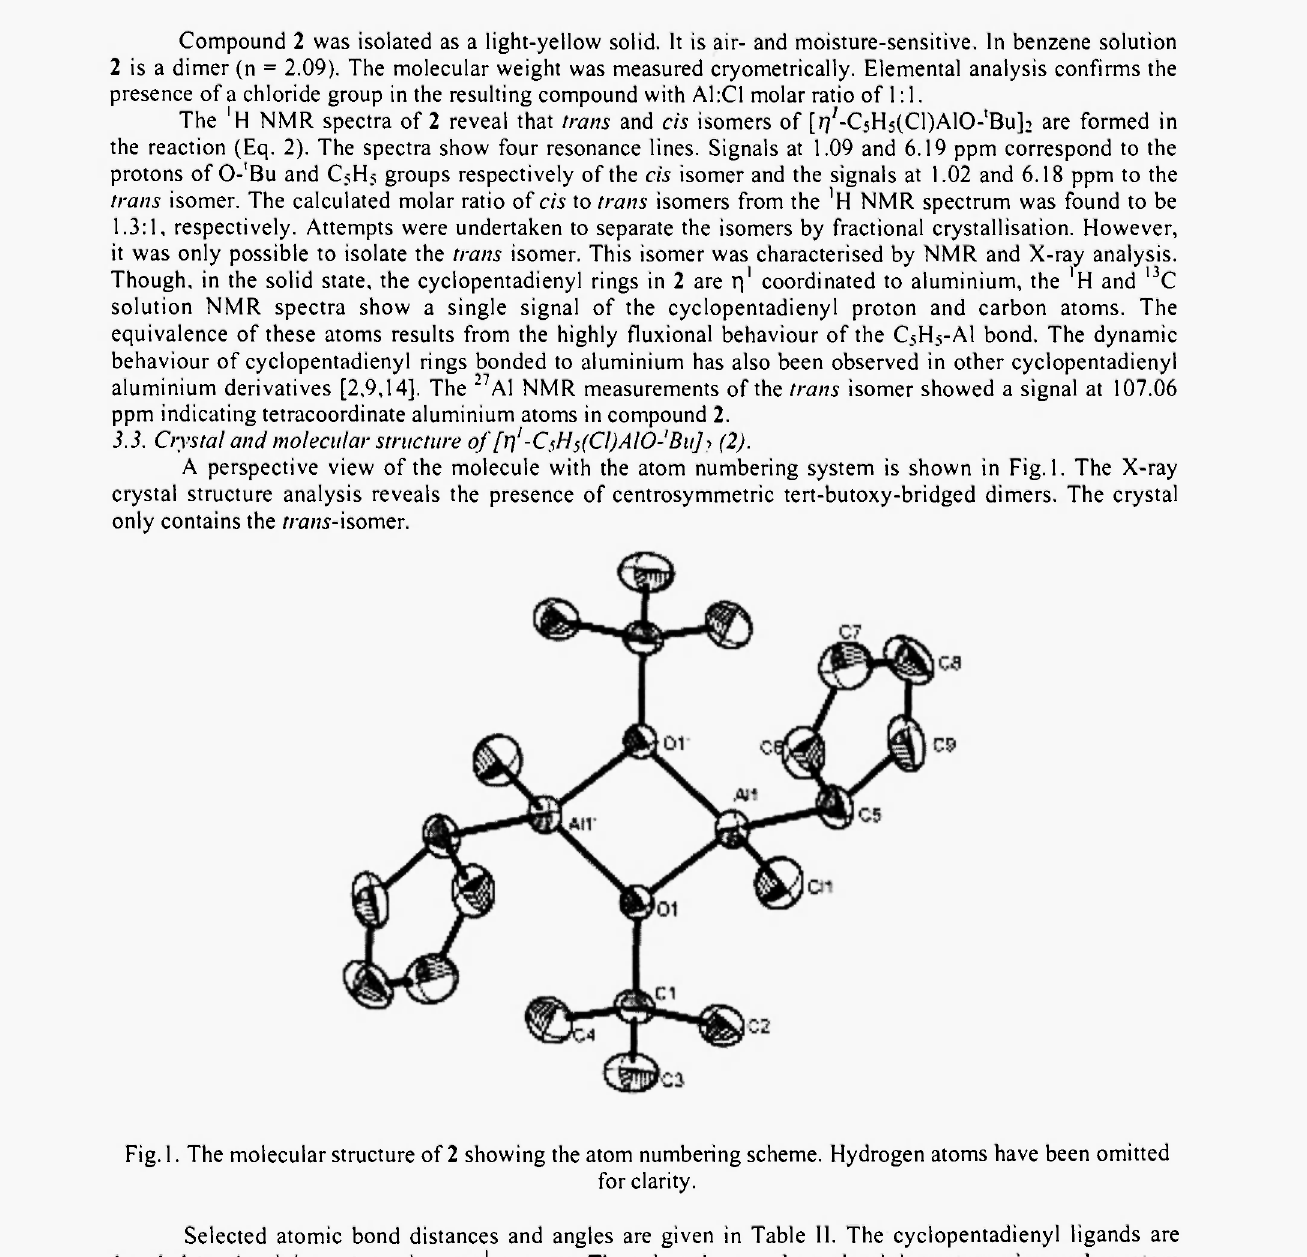
Fig.l. The molecular structure of 2 showing the atom numbering scheme. Hydrogen atoms have been omitted for